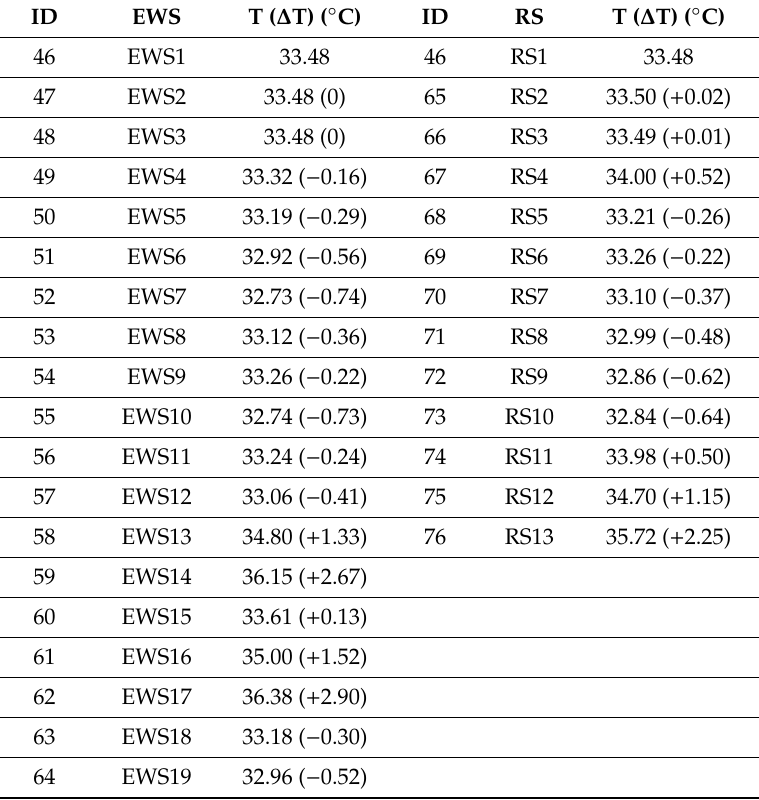
Table 22. External walls and roofing systems considered in numerical simulations and respective thermal performance results (green shading—negative values of ∆ T and orange shading for positive values of ∆